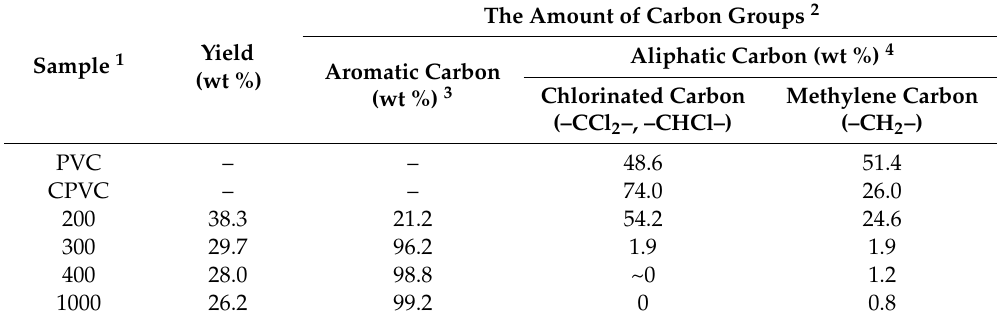
Table 1. The yields and molecular structures of the PVC, CPVC and thermally decomposed Table1. TheyieldsandmolecularstructuresofthePVC,CPVCandthermallydecomposedintermediates intermediates of the CPVC spun fibres and the CPVC-derived carbon fibre. of the CPVC spun fibres and the CPVC-derived carbon fibre.